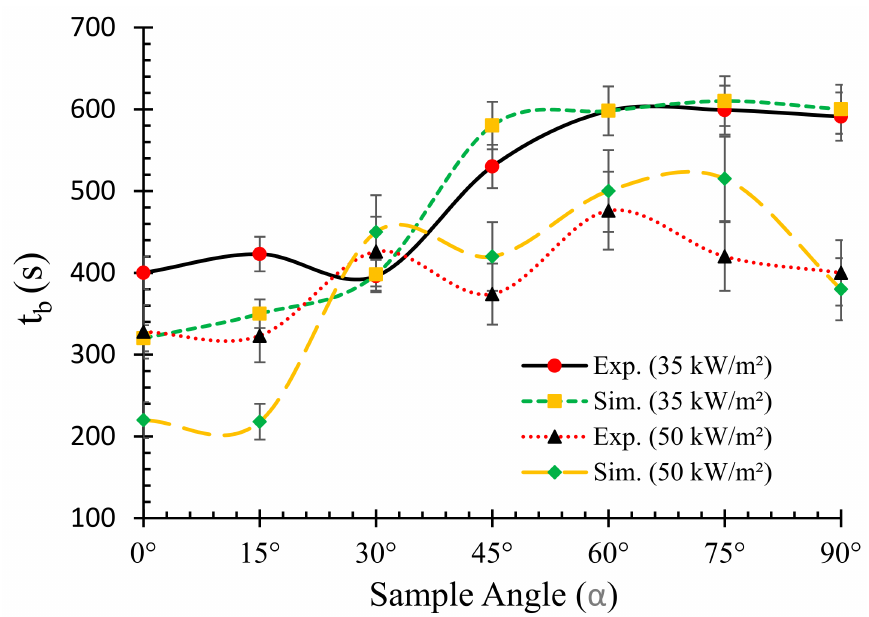
Figure 9. Relationships between the burn times ( t b ) and sample angles ( α ) for two different heat fluxes (0 ◦ = horizontal, 90 ◦ =